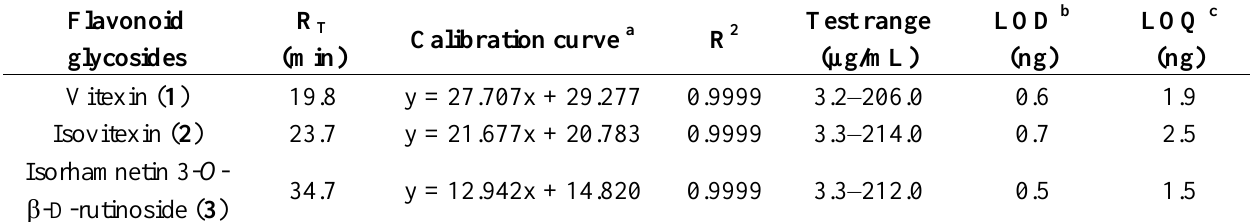
Table 1. Calibration curves and LODs, LOQs for the three flavonoid glycosides 1 – 3 . Flavonoid glycosides